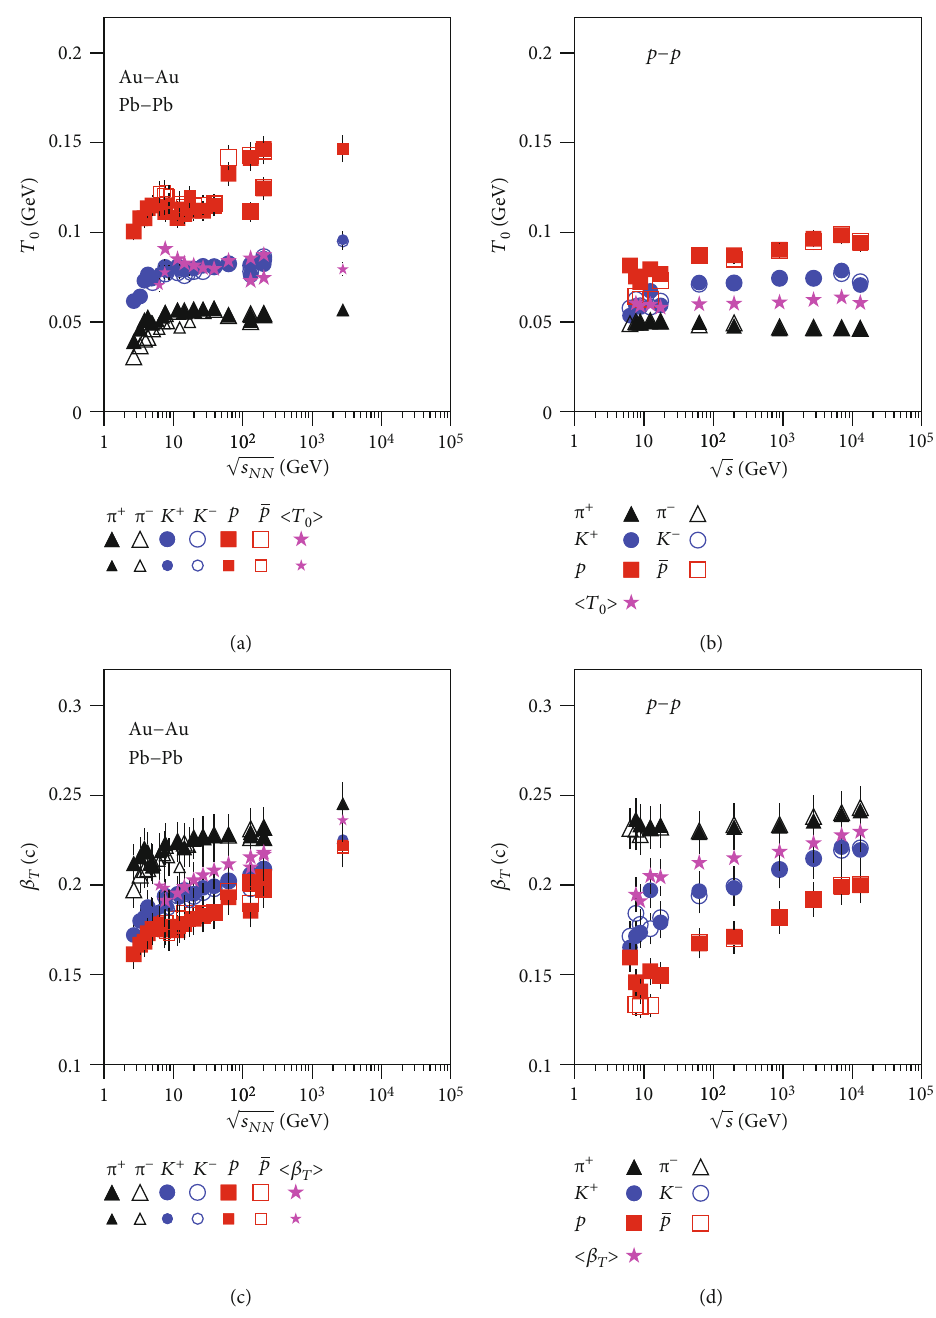
h T i , as well as (c) and (d) β 0 and 0